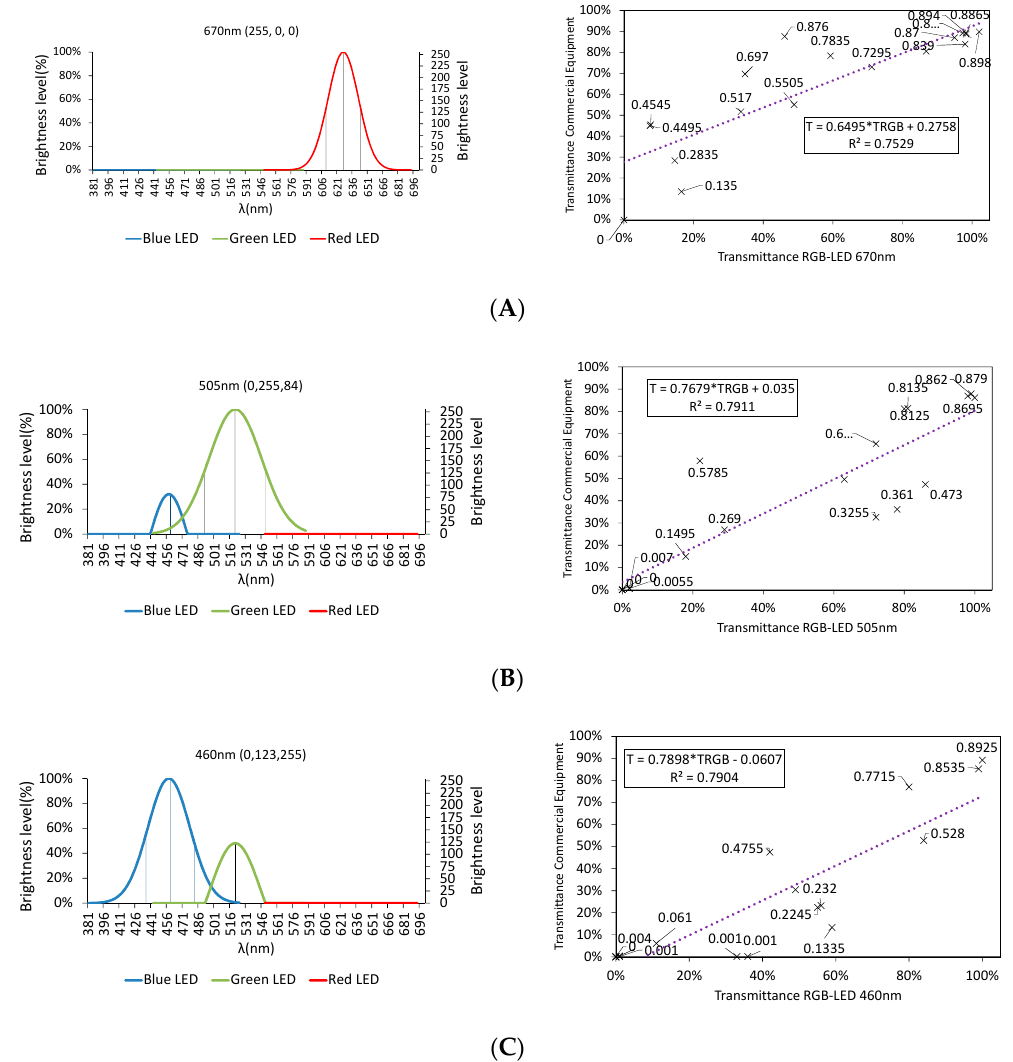
Figure 17. Combination of wavelengths and correlation for: ( A ) 670, ( B ) 505, and ( C ) 460 nm.